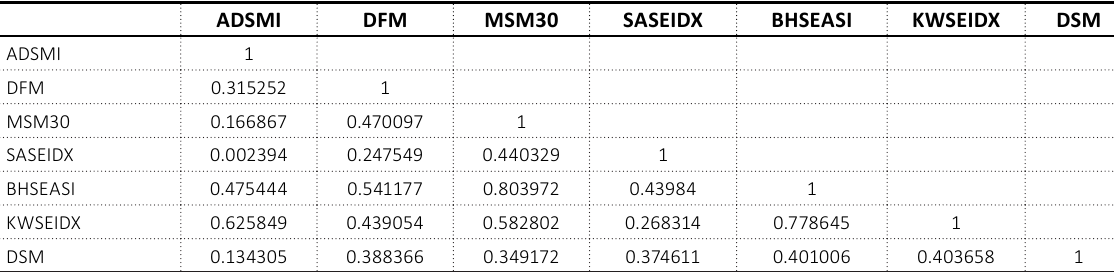
Table 3. Correlation structure in the GCC stock